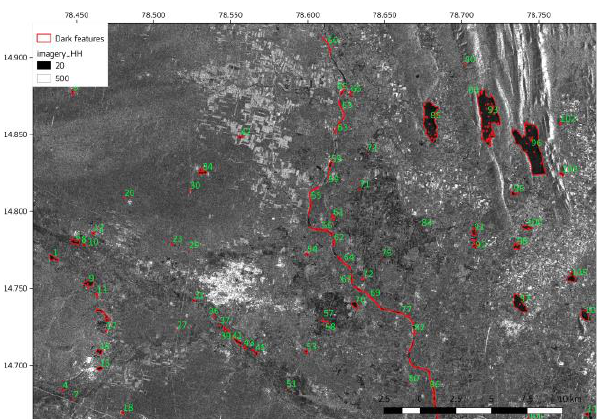
Figure 3: Output vector overlaid on input for a dark feature extraction over land using the proposed